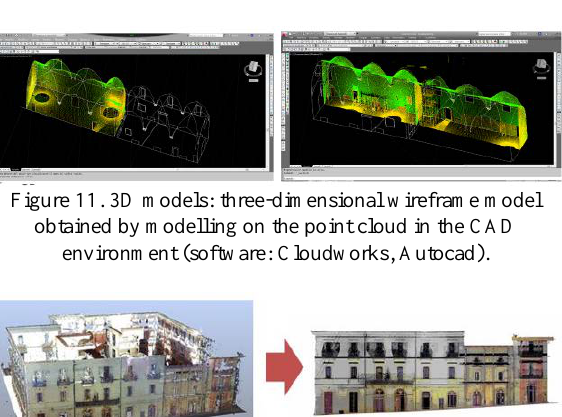
Figure 10. 2D drawings: planimetry and comparison with the previous traditional survey (above) (software: Cloudworks, Autocad). Sections and assessment of deformations (below) (software: Cloudworks, Autocad).